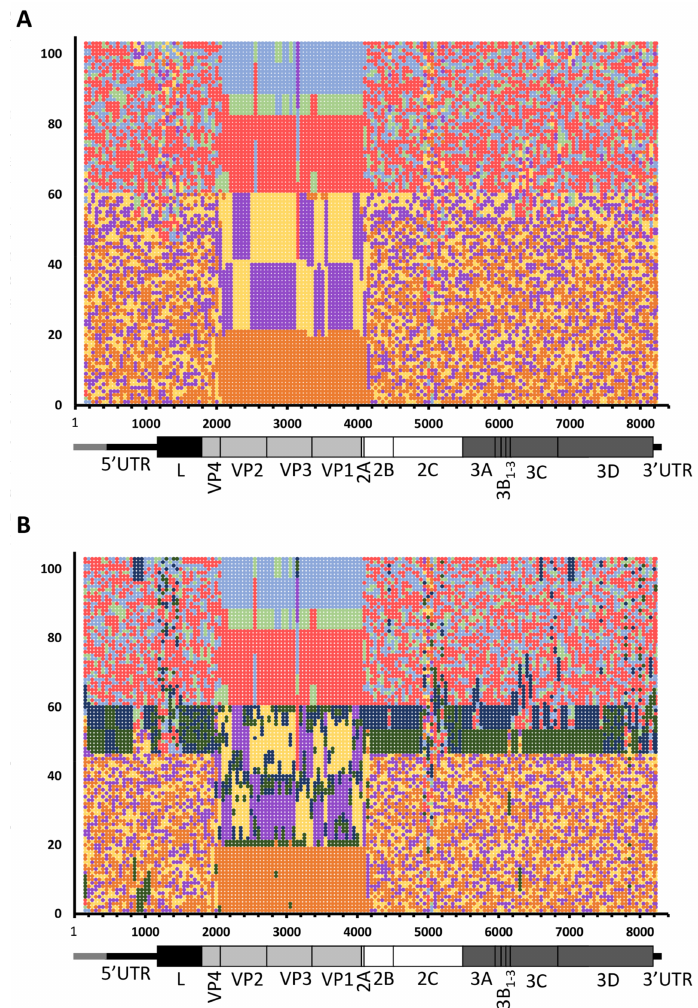
Figure 4. Phylogenetic Signal Scan analysis reveals the extent of distinct phylogenetic signatures of QENP and uEA FMDV lineages. ( A ) Whole genome MSA was subjected to TreeOrder Scan implemented in SSE v.1.3 software using a sliding window of 300 nucleotides with an increment of 50 nucleotides and applying a bootstrap threshold of 70% from 100 replicates for scoring of phylogeny violation. Results of the Phylogenetic Signal Scan were presented in the form of a matrix of tree-order positions against the genomic regions, where serotype A isolates are shown in light blue, serotype C in light green, serotype O in red, SAT 1 in yellow, SAT 2 in purple and SAT 3 in orange; ( B ) As in ( A ), but this time isolates from QENP and uEA clades were marked in dark green and dark blue,